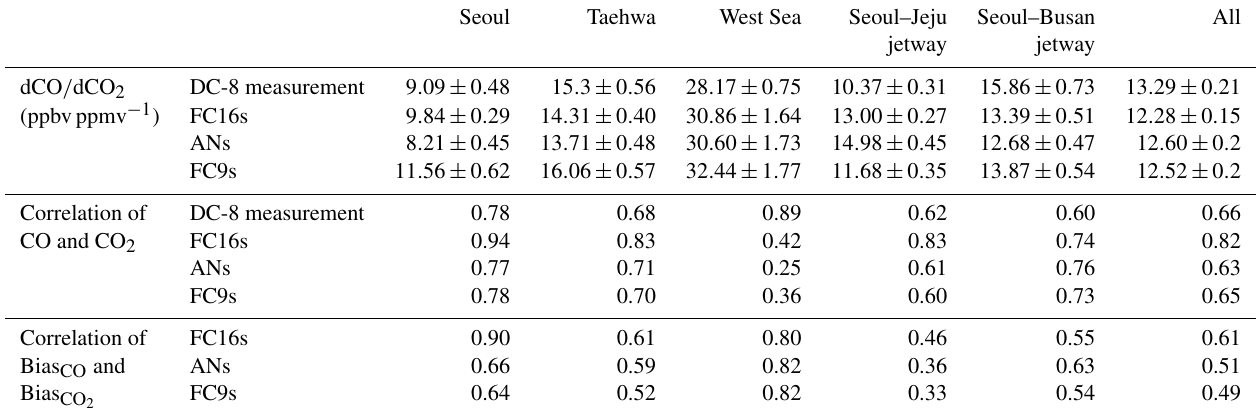
Table 3. Enhancement ratios of CO to CO 2 (ppbvppmv − 1 ), CO and CO 2 correlations, and bias of CO to bias of CO 2 correlations from airborne measurements, CAMS FC16s, ANs, and